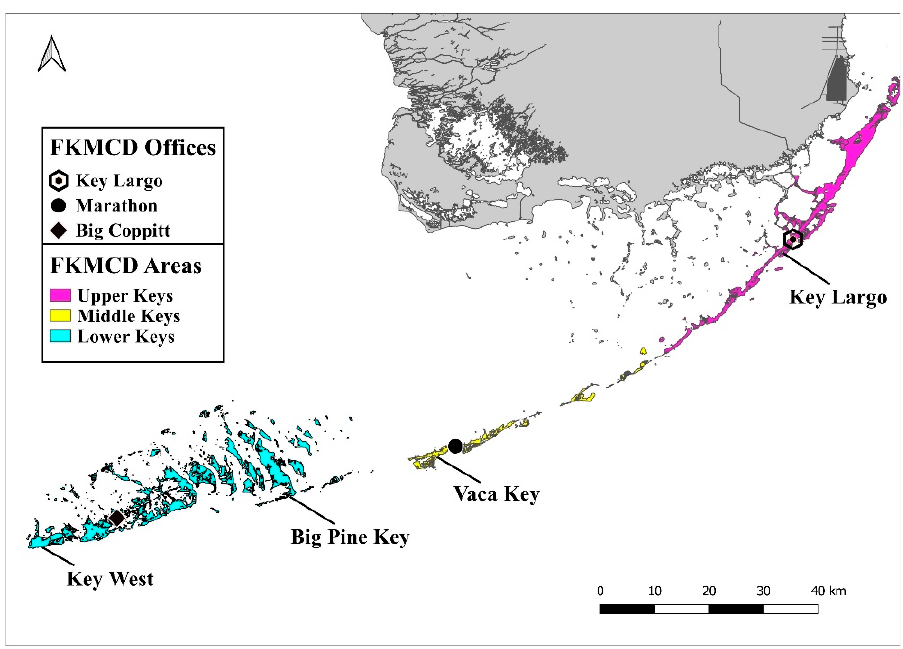
Figure 1. Locations of FKMCD offices, operational areas within the Florida Keys, and localities mentioned in the text.